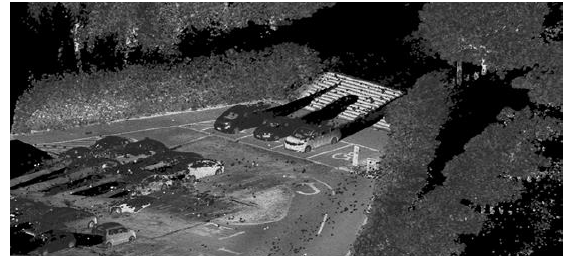
Figure 8. LiDAR data for evaluation of the developed trolley- loading system